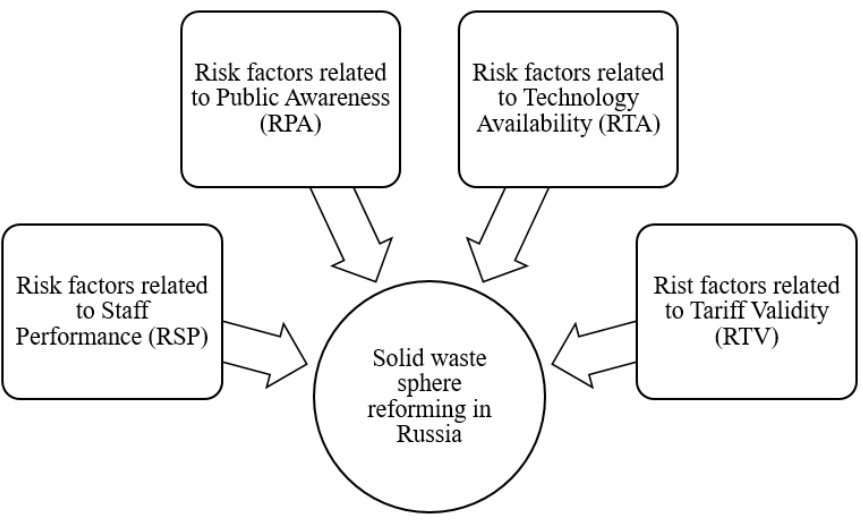
Figure 1. Groups of risk factors affecting the solid waste sphere reforming in Russia.